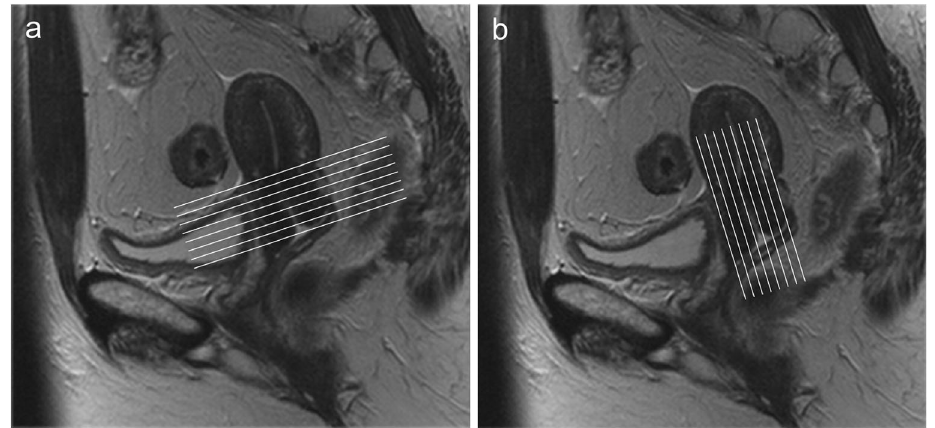
Fig. 1 Sagittal T2-weighted im- age. The oblique axial ( a ) and coronal planes ( b ) are orientated to the plane of the cervical